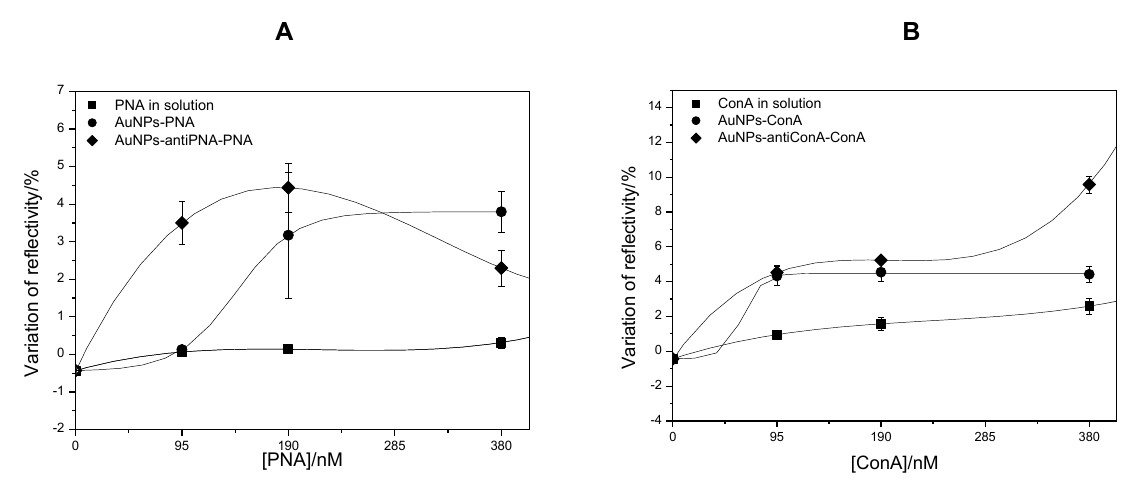
Figure 5. Mean value and standard deviation of the variation of reflectivity on spots of antibody anti-PNA ( A ) and antibody anti-ConA ( B ) after injection of free PNA ( A ) and ConA ( B ) in solution, covalently linked to gold NPs and captured by gold NPs functionalized with anti-PNA or